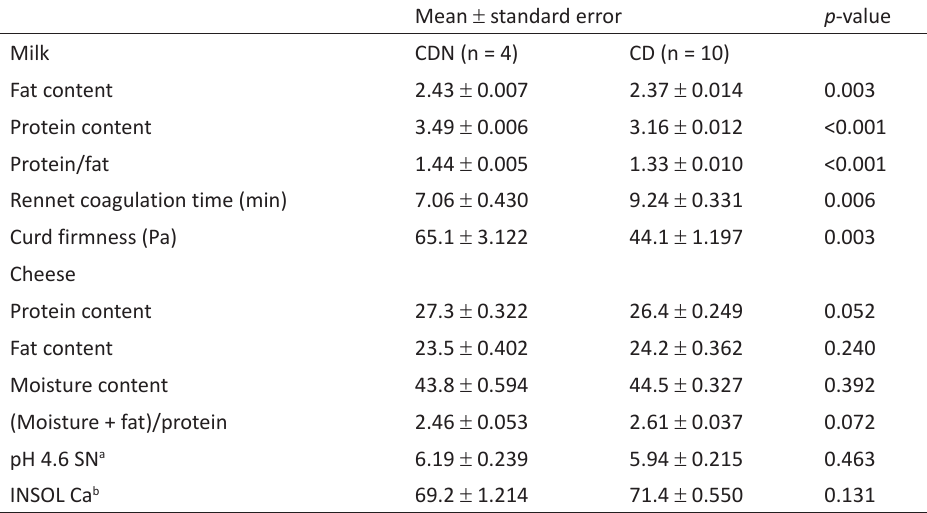
Fig.1. Changes in storage modulus (G’), loss modulus (G’’) and loss tangent (tan δ) at 10 rad s -1 of Edam type cheeses processed with bulk set culture (open symbols; n=7) and direct vat set culture (filled symbols; n=7). The results are expressed as overall means (figures A, B and C) and means of five BS and five DVS cheeses with drop of G’ and G’’ in the second week (squares in figures A’, B’ and C’) and two BS and two DVS cheeses without drop (circles in figures A’, B’ and C’). The error bars represent the standard error for each time point. Table 3. Composition (%) of cheese milk and cheeses without (CDN) and with (CD) sudden drop of elastic (G’) and loss (G’’) modulus in the second week of